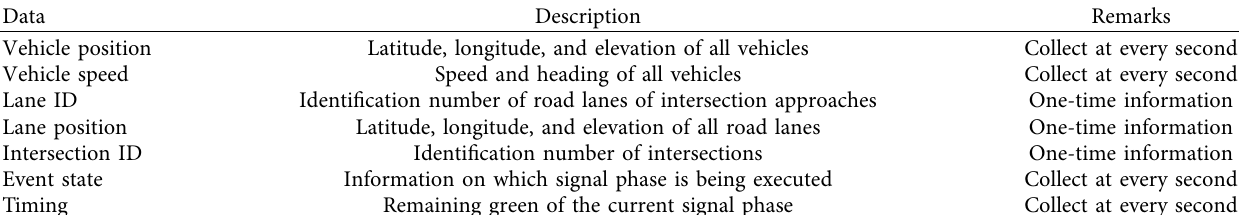
Table 1: Arrangement of V2X-based data required for signal control.